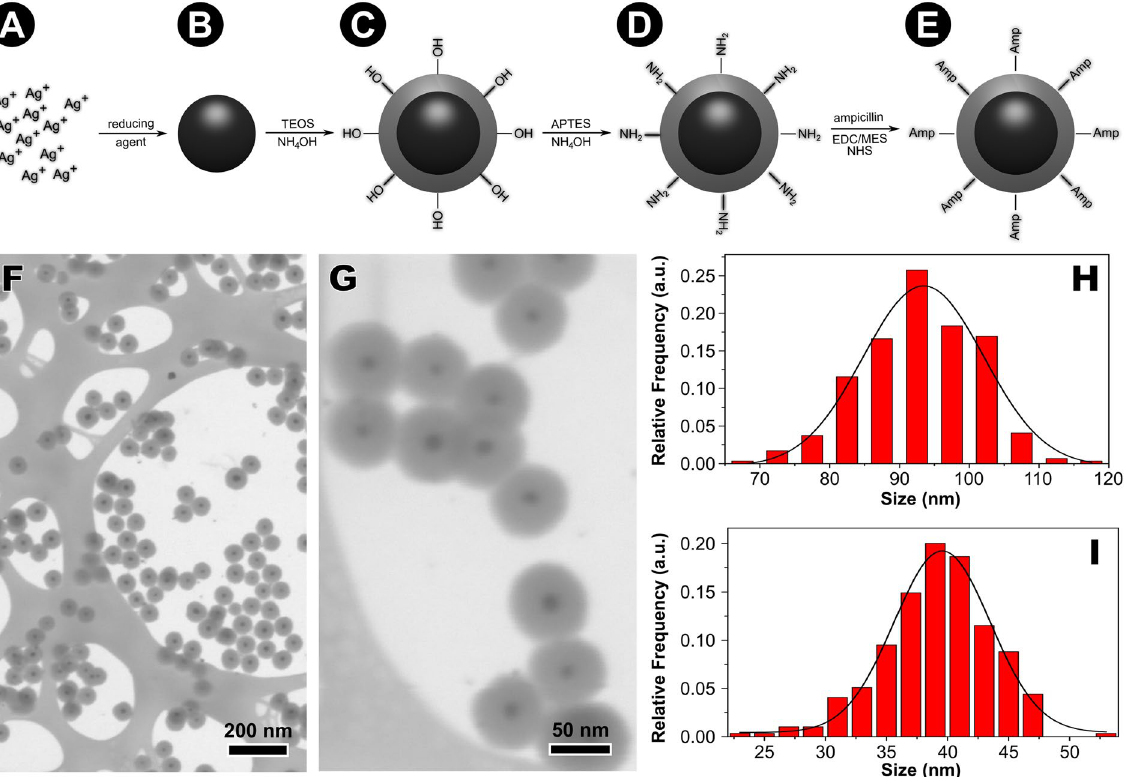
Figure 1. Synthesis steps to obtain silver nanoparticles functionalized with ampicillin. AgNPs ( B ) were formed by the reduction reaction of silver nitrate ( A ) in the presence of a reducing agent (the stabilizer is not shown for simplicity). Then a silica shell was produced by hydrolysis and condensation of tetraethyl orthosilicate (TEOS) and the produced core-shell Ag@SiO 2 system is shown in ( C ). These nanoparticles are then coated with a thin silica layer (made of 3-aminopropyl triethoxysilane - APTES) to give a core-shell system with amino groups located on the surface of the nanoparticle ( D ). Finally, the amino-functionalized nanoparticles react with ampicillin to form the structure schematized in ( E ). This scheme is merely illustrative and is not in proportion to the actual size of the system. Transmission electron microscopy images of Ag@SiO 2 nanoparticles obtained at ( F ) low and ( G ) high magnification. Core-shell ( H ) and shell thickness ( I ) size distributions obtained from TEM